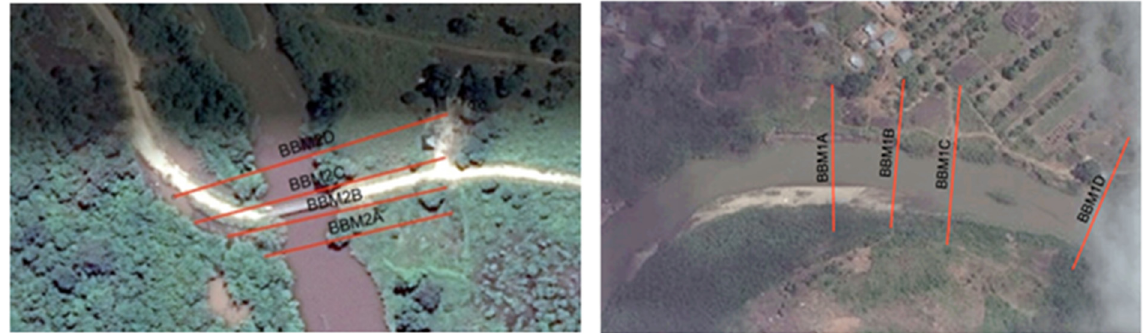
Figure 2. Channel cross-section depth survey transects at Gama Gate ( left ) and Matipwili ( right ), Wami River, Tanzania.